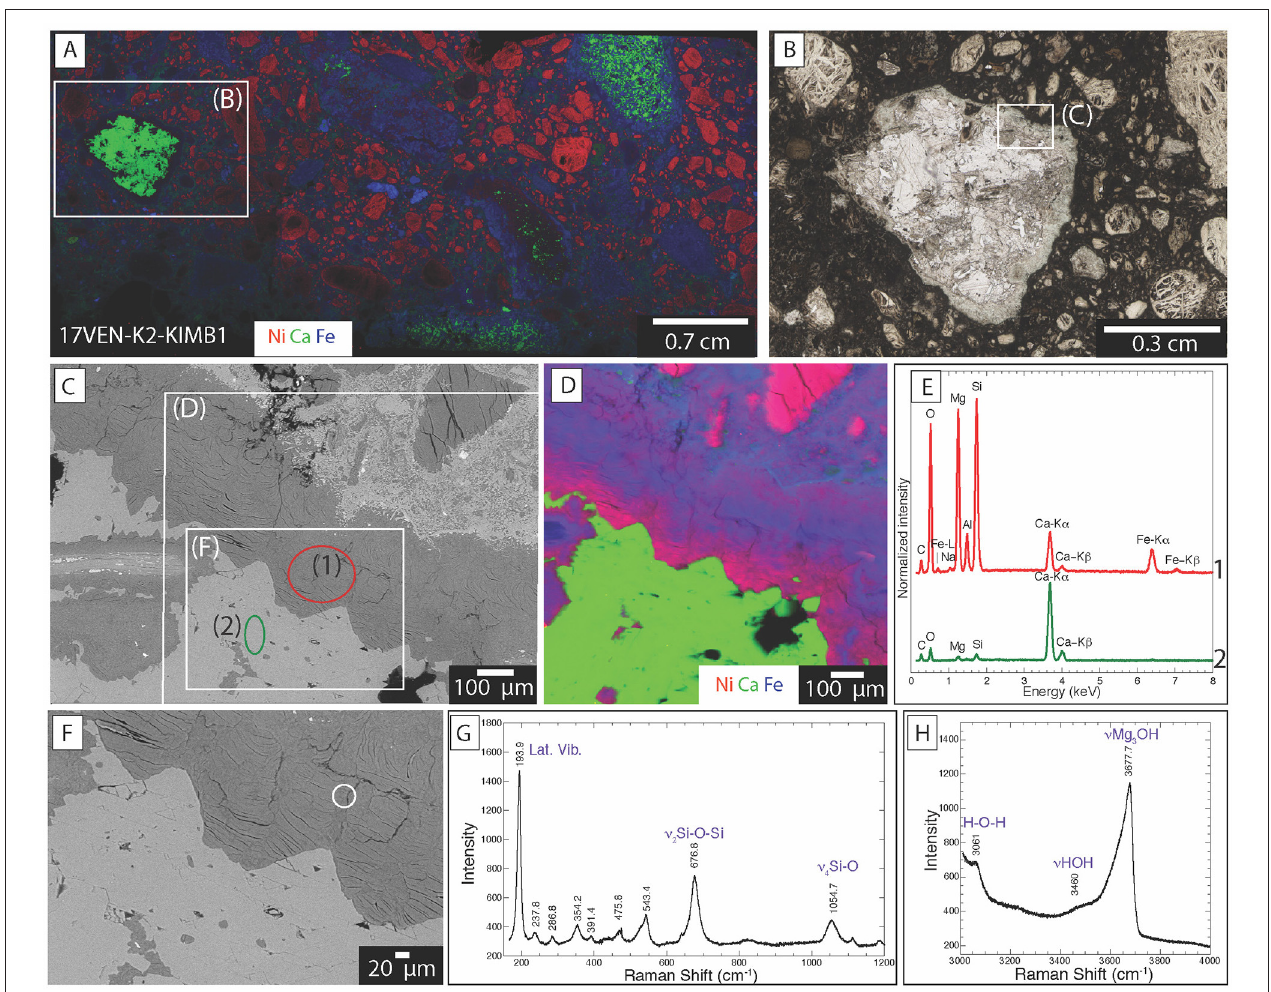
FIGURE 7 | Distribution of mineral phases within kimberlite ores from Venetia (17VEN-K2-KIMB1) (A) XFM map showing the distribution of Ni (red), Ca (green) and Fe (blue) of the entire thin section. The red, green and blue colors correspond to the measured intensities of the Ni K-alpha, Ca K-alpha and Fe K-alpha emission lines, with the brightest color, the highest measured count rate and black corresponding to the lowest count rate; (B) Optical photograph of the area marked by a rectangle on (A) showing agglomeration of calcite crystals; (C) Backscattered electron image of the area marked by a rectangle in (B) at the interface between the matrix and the polycrystalline calcite grain; (D) XFM map showing the distribution of Ni, Ca and Fe. The red, green and blue colors correspond to the measured intensities of the Ni K-alpha, Ca K-alpha and Fe K-alpha emission lines, with the brightest color, the highest measured count rate and black corresponding to the lowest count rate. (E) Backscattered image of the area marked on (C) ; (G,H) Raman spectra of the areas circled in (F)